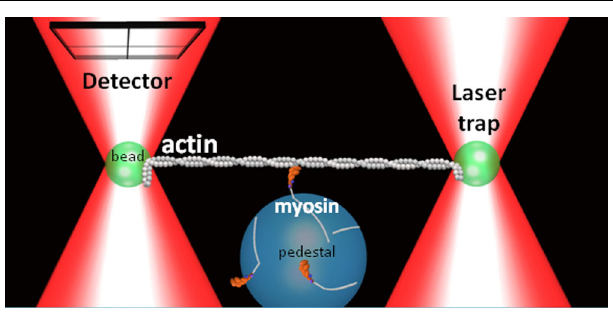
FIGURE 2 |Three-bead laser trap assay. A schematic representation of the three-bead laser trap assay showing a single myosin molecule interacting with a single actin filament. A quadrant photodiode detector tracks the motion a trapped bead connected to the actin